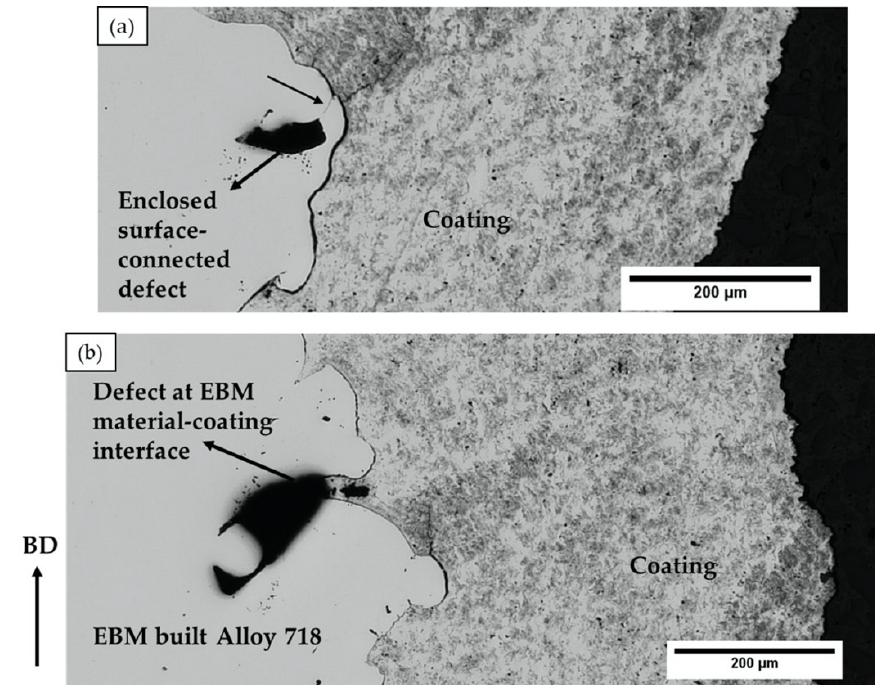
Figure 5. LOM micrographs showing ( a ) an enclosed defect in the EBM material and ( b ) a defect at the EBM material-coating interface in the as-built condition. The arrow on the left indicates the build direction.